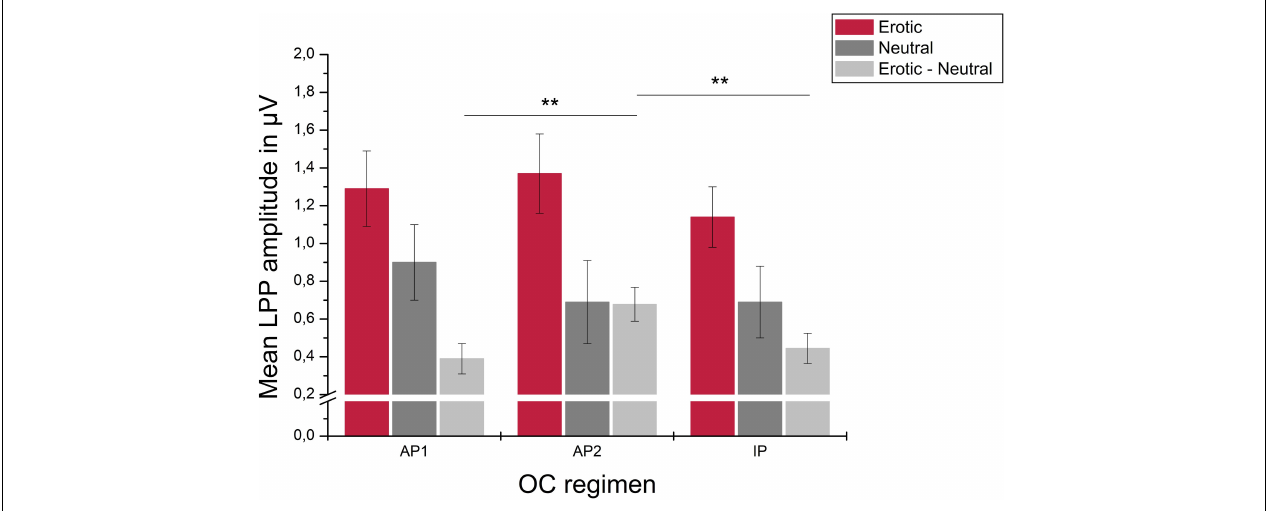
FIGURE 9 | Mean LPP amplitudes in µ V averaged over electrodes CP1, CP2, P1, and P2 in reaction to erotic and neutral stimuli as well as the erotic – neutral difference in OC users across active OC pill phase one (AP1), active OC pill phase two (AP2) and the inactive OC pill phase (lP). Error bars reflect SEM. ** p <